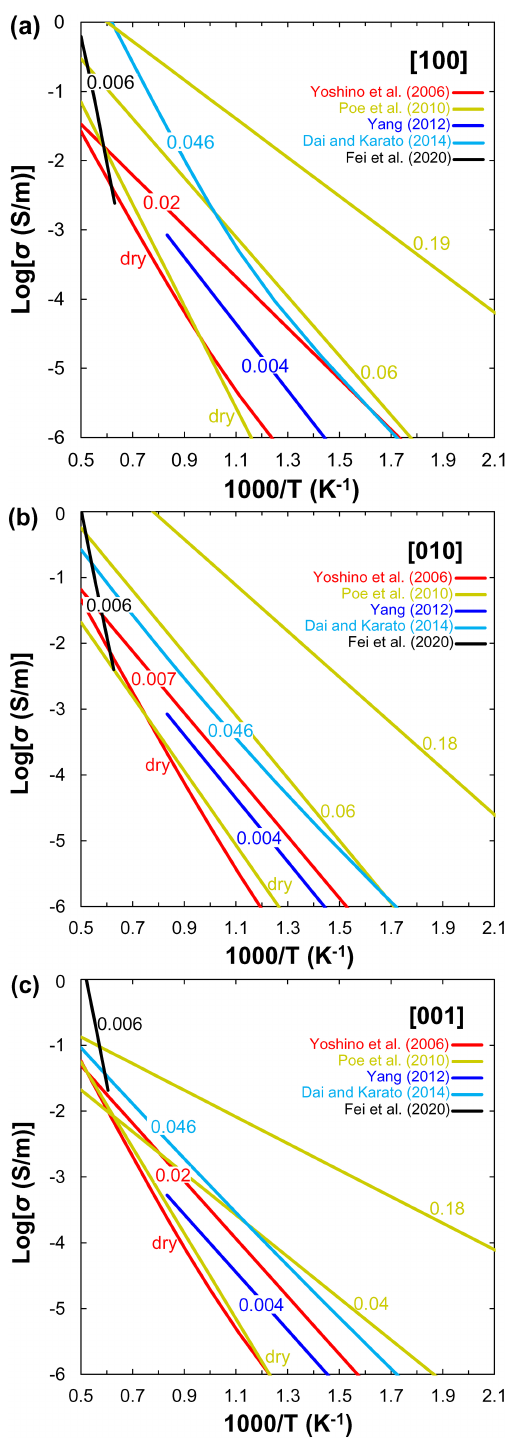
Figure 4. Compilation of electrical conductivity data of single- crystal hydrous olivine for (a) [100], (b) [010] and (c) [001] crys- tallographic directions as a function of reciprocal temperature. The number labels indicate water content in weight